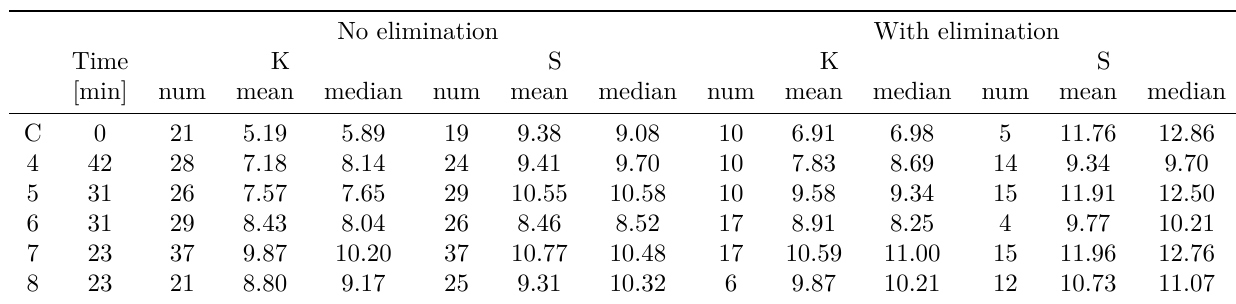
Table 5. Young’s moduli from tensile tests in [GPa] with or without elimination.